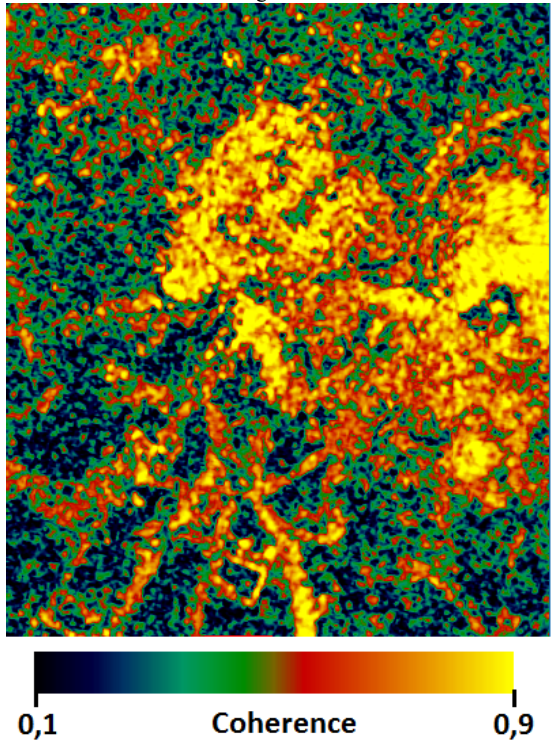
Figure 5. Image showing the Erfoud town SAR coherence data.